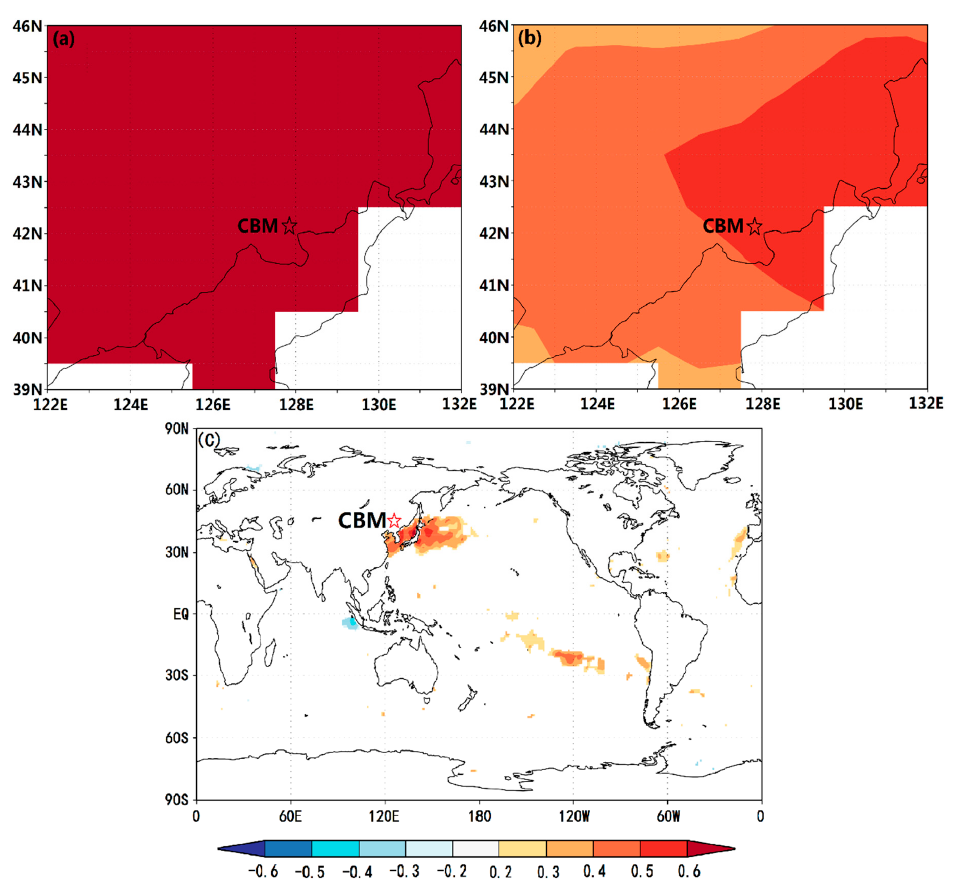
Figure 9. Spatial correlation of ( a ) observed and ( b ) reconstructed June–July temperatures with regional gridded June–July temperatures from 1959 to 2004. ( c ) Spatial correlation for the reconstruction with June–July averaged HadlSST1 SST (sea surface temperatures) during the period of 1870–2004 (http://climexp.knmi.nl). The asterisk mark is the sampling position. The cycles of 9.7 and 11.1 years may suggest the influence of solar effects, such as the amount of solar irradiance [69–72]. Correlation analyses revealed that the Tmax6–7 series had a significant positive correlation with the number of sunspots (http://www.sidc.be/silso/datafiles) from May to July of the current year ( n = 233, 1772–2004, r = 0.21, p = 0.011), indicating that the Tmax6–7 series was most likely influenced by solar activity. An approximately 10-year cycle was detected from other works in northern China and suggests the effects of solar activity [14,19,27]. The significant spectral peaks appearing in 15.5, 17.9, 29.1, and 69.7 years may be related to the 15–30 and 50–70 year periods of the Pacific decadal oscillation (PDO) [73–75], which was confirmed by the significant positive correlation of the reconstructed Tmax6–7 series with the annual PDO ( n = 225, r = 0.37, p < 0.05; 1772–1996) [76] and with SSTs in the eastern Pacific Ocean (Figure 9c). Some other works which were conducted near our study region discovered that the reconstructed climate series based on the tree-ring widths of Hailar pine, Mongolian pine, and Pinus tabulaeformis were also significantly correlated with the PDO [15,27,61]. As mentioned above, the complex connections between the solar activity, ENSO, and PDO suggest that the temperature in the CBM area indicated local-regional climate signals and global- scale climate changes.